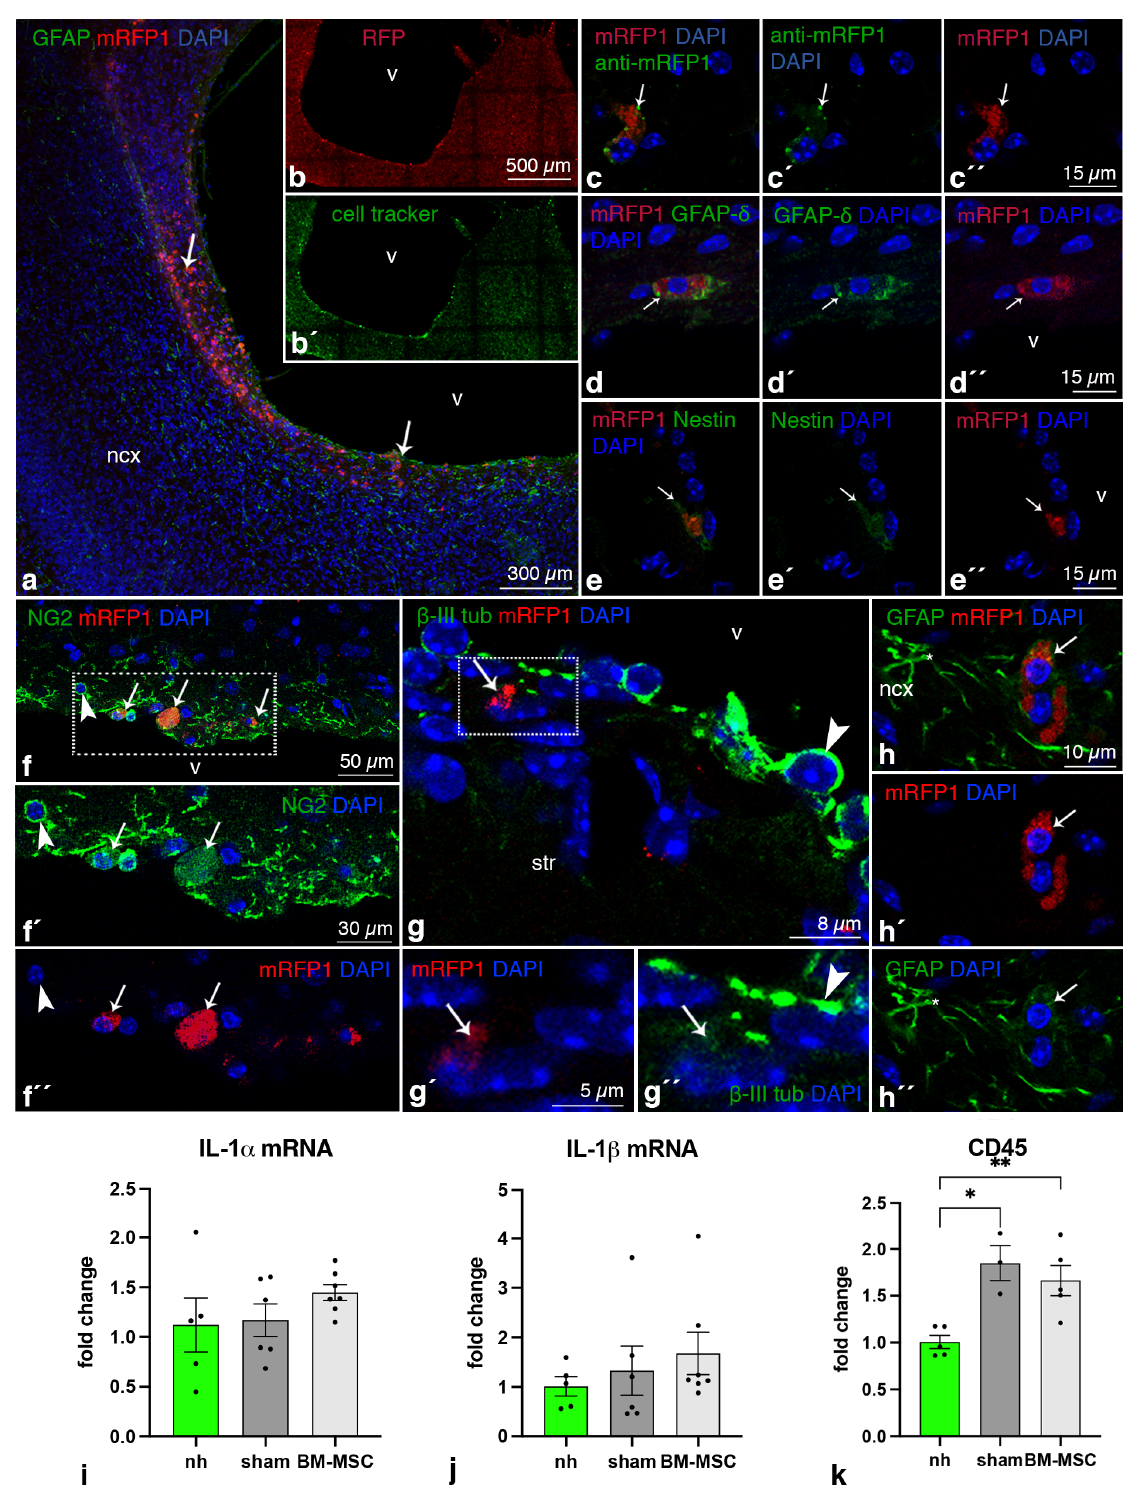
Figure 1. Integration of BM-MSCs into the periventricular cerebral tissue of hydrocephalic hyh mice. ( a ) Wall of the neocortical (ncx) lateral ventricle (v) of a hydrocephalic hyh mouse at P18; administered BM-MSCs (white arrows, mRFP1 fluorescence in red) at P4. BM-MSCs are located between periventricular reactive astrocytes (GFAP, green). ( b , b′ ) Separated channels showing fluorescence of the green cell tracker and mRFP1 (red) in the transplanted BM-MSCs. ( c , c′ , c″ ) Labeling of BM- MSCs (arrow, mRFP1 fluorescence in red) with an antibody against mRFP1 (green, white arrow). Expression of ( d , d′ , d″ ) δGFAP (green), ( e , e′ , e″ ) nestin (green), ( f – f″ ) NG2 (green), ( g – g″ ) βIII-